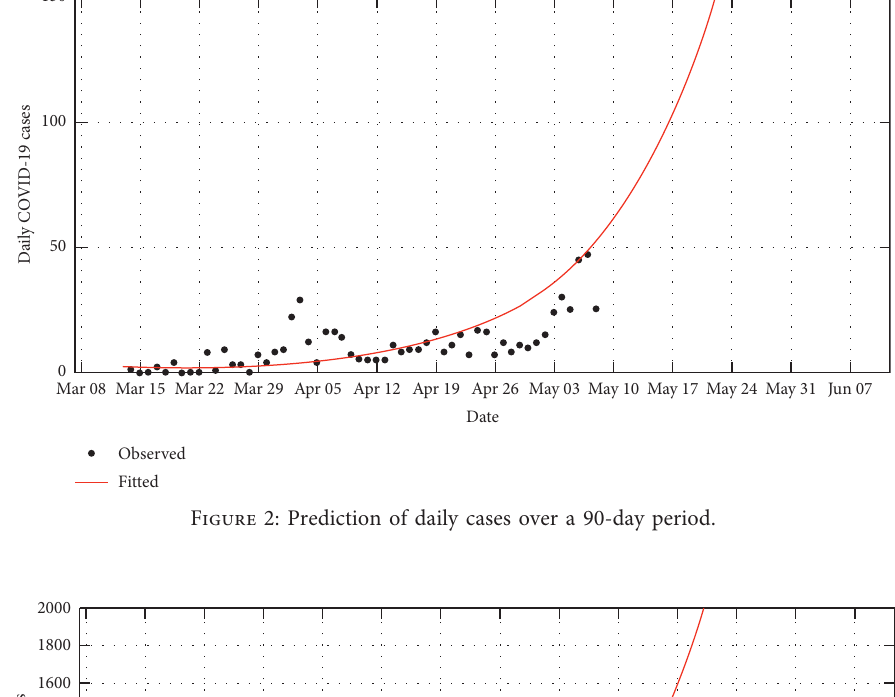
Figure 2: Prediction of daily cases over a 90-day period.